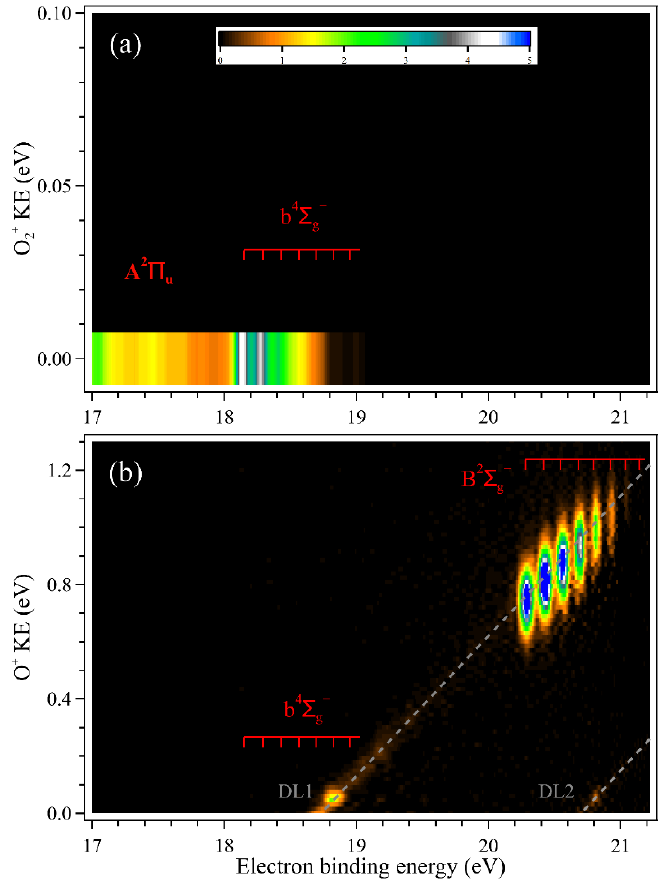
Figure 5. Electron and ion kinetic energy correlation diagram corresponding to ( a ) the O 2+ parent ion and ( b ) the O + fragment ion, with the assignments along the O + ( 4 S) + O( 3 P) and O + ( 4 S) + O( 1 D) dissociation channels. As shown in the inserted color panel, the ion signal intensity increases from orange to white then blue, with black representing zero.